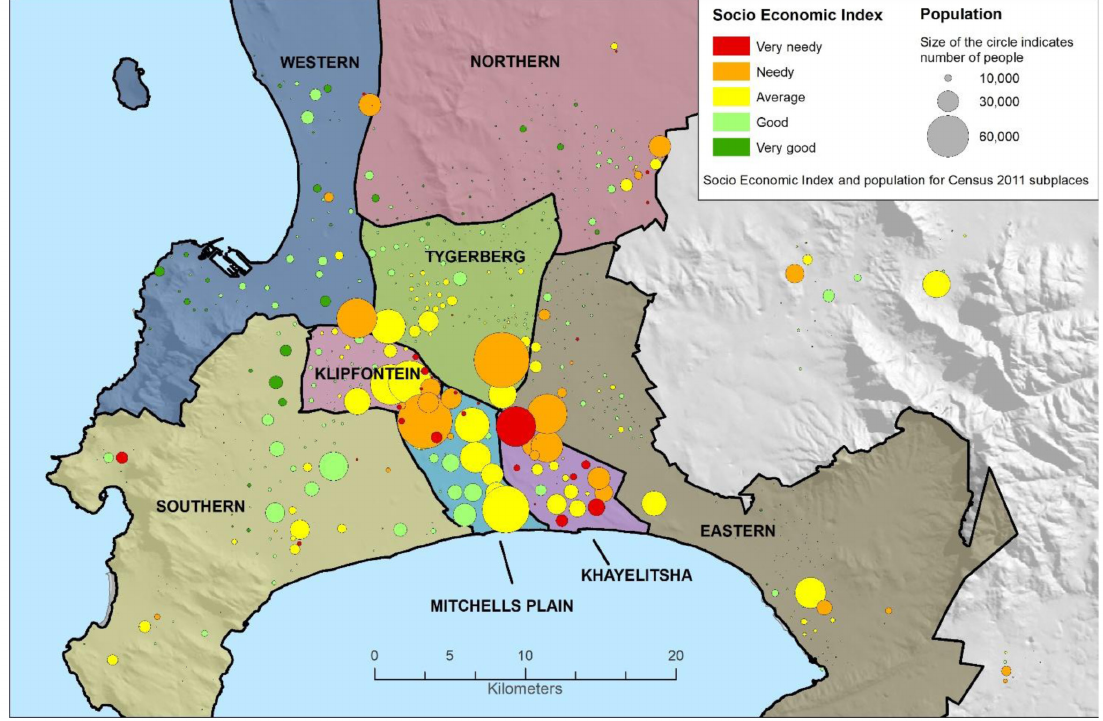
Figure 1. Map of Cape Town Metro, with socio-economic index and population size taken from the 2011 Census 3 . Graphic courtesy of the Western Cape Department of